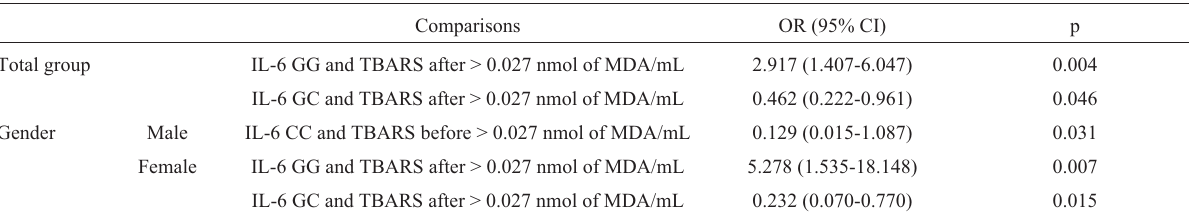
Table 9 - Odds ratios (OR) and 95% confidence intervals